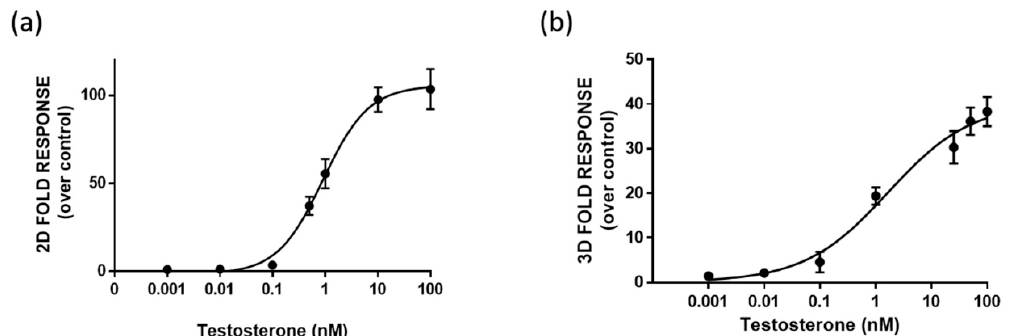
Figure 4. Dose-response curve for testosterone obtained in 2D cell culture ( a ) and 3D cell culture models ( b ). HEK293 cells were co-transfected with LgBiT-hAR and hAR-SmBiT under the regulation of the SV40 promoter and treated at 48 h with testosterone. BL measurements were obtained after the addition of Nano-Glo ® Live Cell Assay System substrate. The results are expressed as the fold response over basal control activity. Data are the mean ± s.d. of at least three independent experiments, each performed in triplicate.